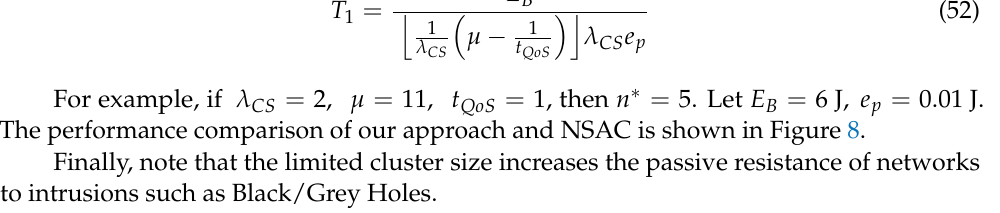
Figure 7. The cluster size’s allowed limit versus the packet latency defined by the quality of service (QoS) policy.